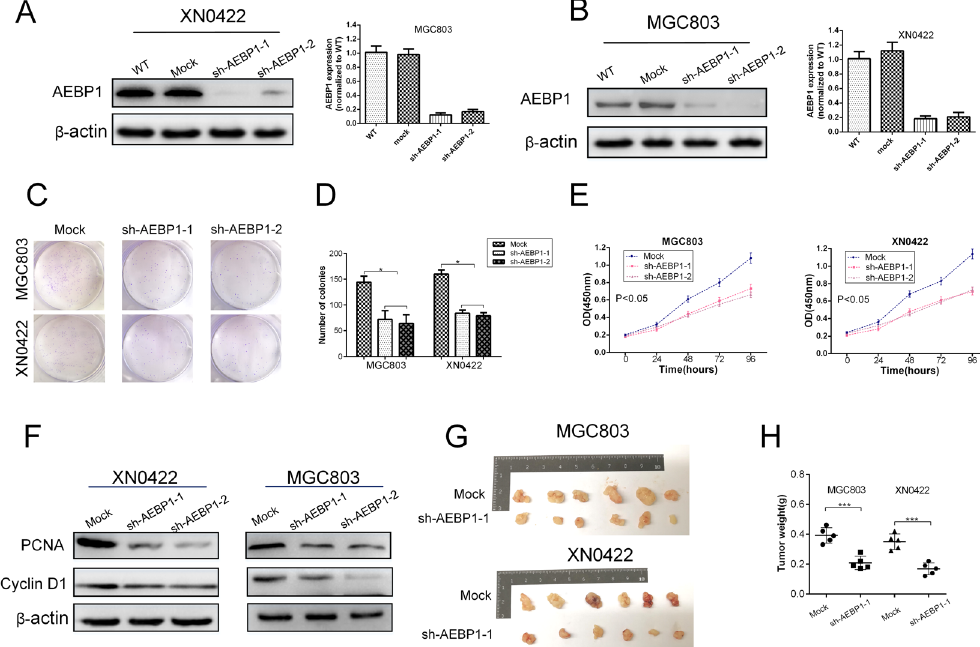
Figure 4. Silencing AEBP1 reduces the proliferation of gastric cancer cells. ( A ) The knockdown efficiencies of AEBP1 in MGC803 and XN0422 were confirmed by Western blotting and qRT-PCR ( B ) analyses; * P < 0.05, ** P < 0.01. ( C ) Representative images of colonies formed in sh-AEBP1 and mock MGC803 and XN0422 cells. ( D ) Histograms showing the number of colonies. The means ± standard deviations from three independent experiments were shown; * P < 0.05. ( E ) CCK-8 assays showing impaired proliferation ability of MGC803 and XN0422 cells with knockdown of AEBP1. ( F ) Western blotting analyses of PCNA and cyclin D1 in AEBP1- knockdown and mock cells. ( G ) Formation of subcutaneous xenograft tumors by mock and sh-AEBP1 cells. ( H ) Analysis of the weight of xenograft tumors; *** P < 0.001. The western blots were derived under the same experimental conditions from the same cell lysates; the original full-length Western blot images are shown in Supplementary Fig.